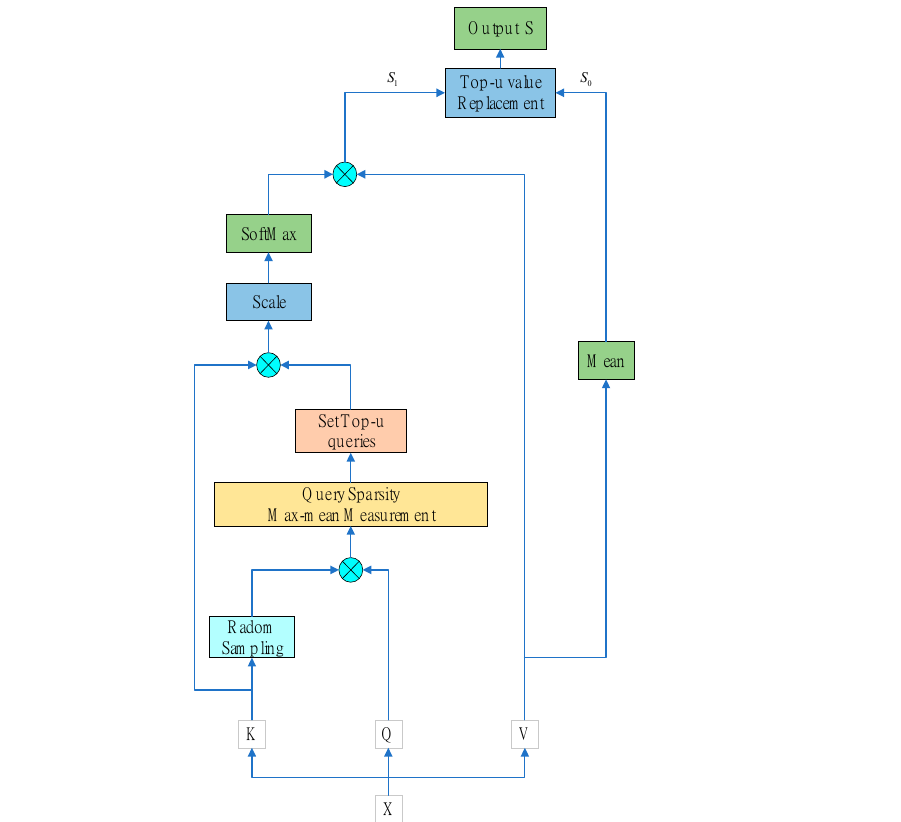
To solve the self-attention problem, Zhou et al. [32] proposed using a probabilistic